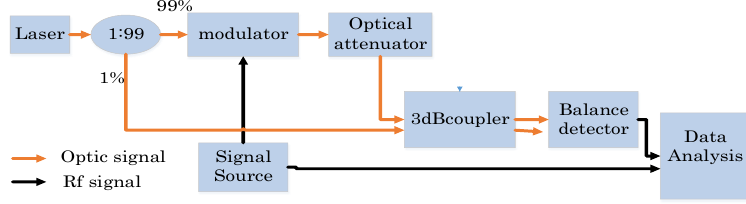
Figure 7. The block diagram of the sensitivity Figure 7 . The block diagram of the sensitivity test.